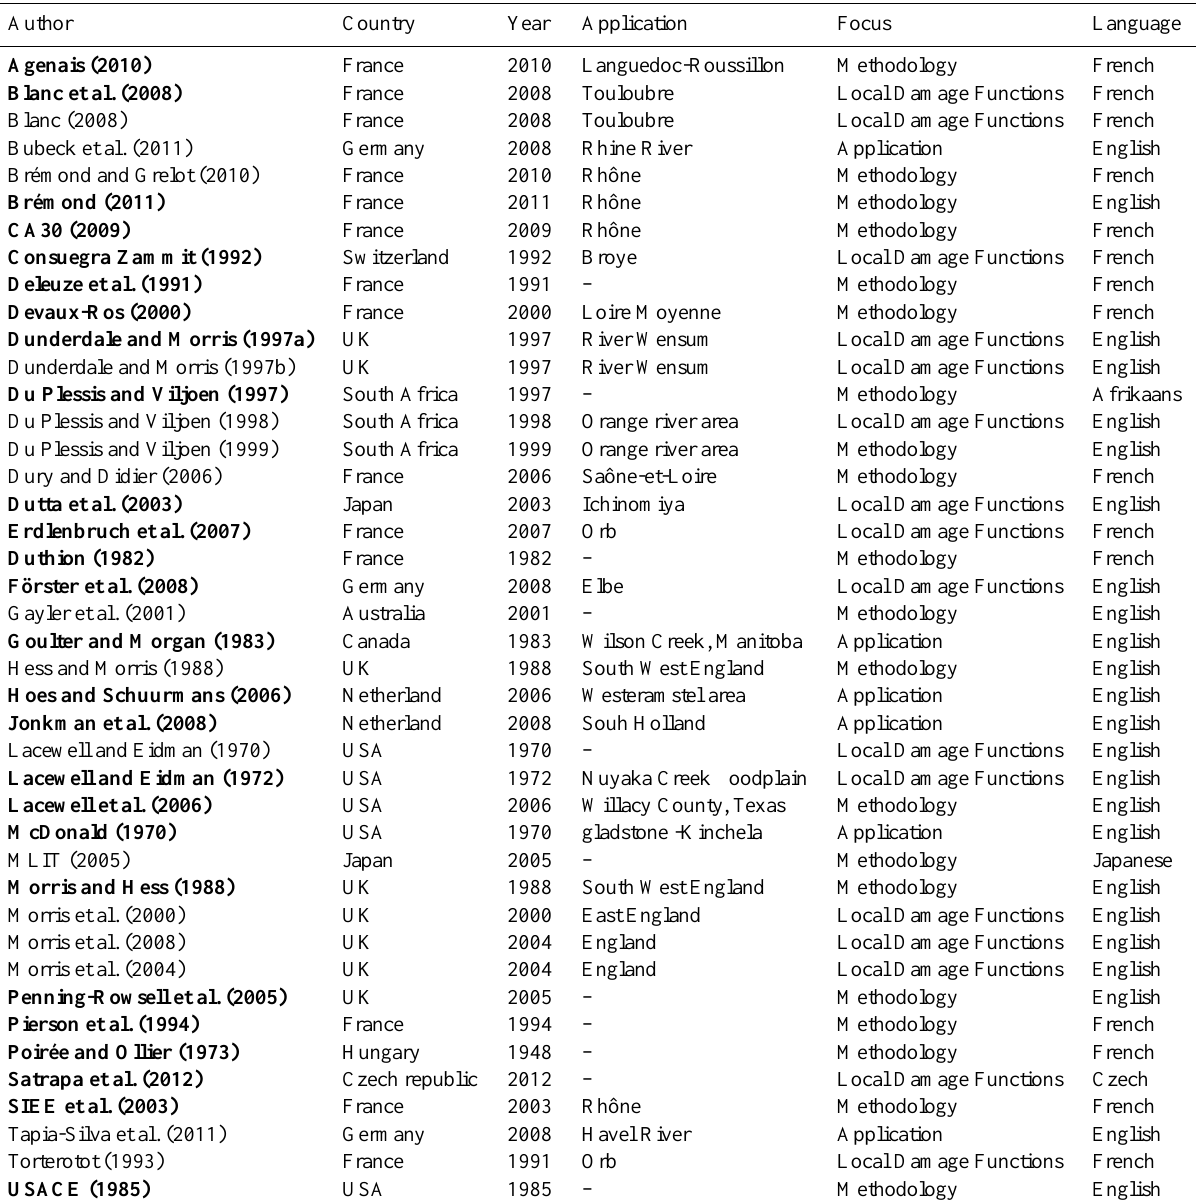
Table 2. Main characteristics of studies dealing with flood damage functions to agriculture (references highlighted in bold are analysed in